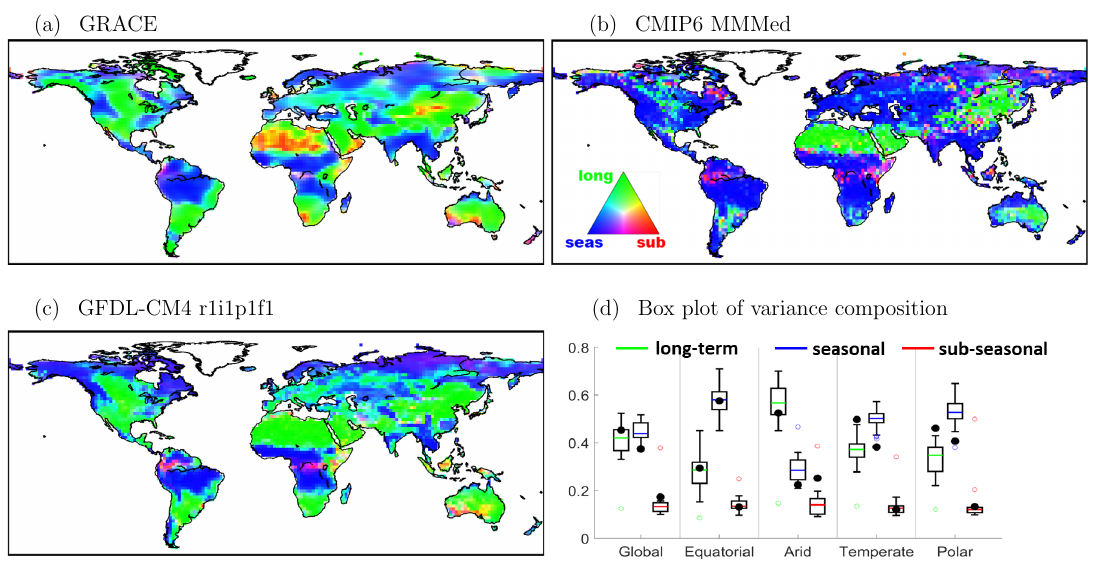
Figure 2. Distribution of the total variance into long-term, seasonal and sub-seasonal variability for the time span 2002/04–2020/04 for ( a ) the GRACE TWS observations, ( b ) the MMMed of the simulated mTWS, ( c ) an exemplary individual model run (GFDL-CM4 r1i1p1f1). ( d ) Box plot of the variance composition within the model ensemble for the global average and averaged over different climate zones. Black dots denote the respective result for the GRACE